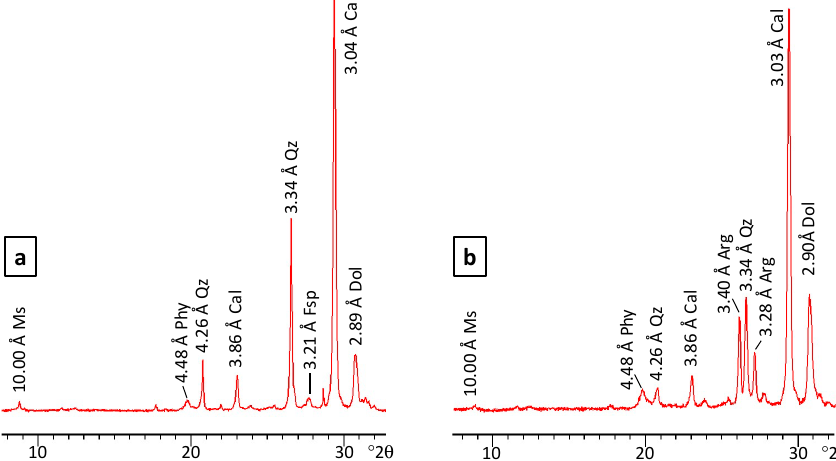
Figure 12. Representative XRD patterns of samples from the damage zones of the Baza Fault (Altichuelas site). ( a ) Calcite-rich samples from portions of non-deformed lithotypes. ( b ) Aragonite and dolomite-rich samples with low permeability values. Cal: Calcite, Dol: Dolomite, Arg: Aragonite, Qz: Quartz, Fsp: Feldspars, Phy: Phyllosilicates, Ms: Muscovite. Mineral abbreviations according to Whitney and Evans [80].